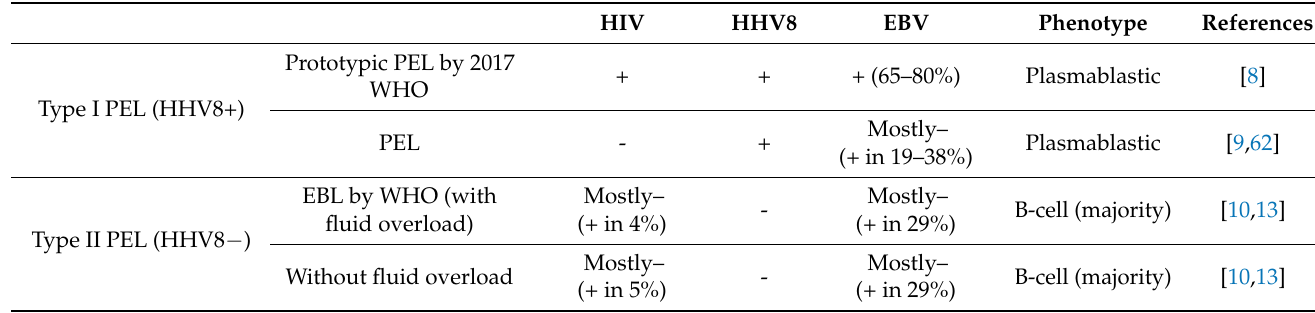
Table 1. The spectrum of PEL in terms of viral infection and phenotype.